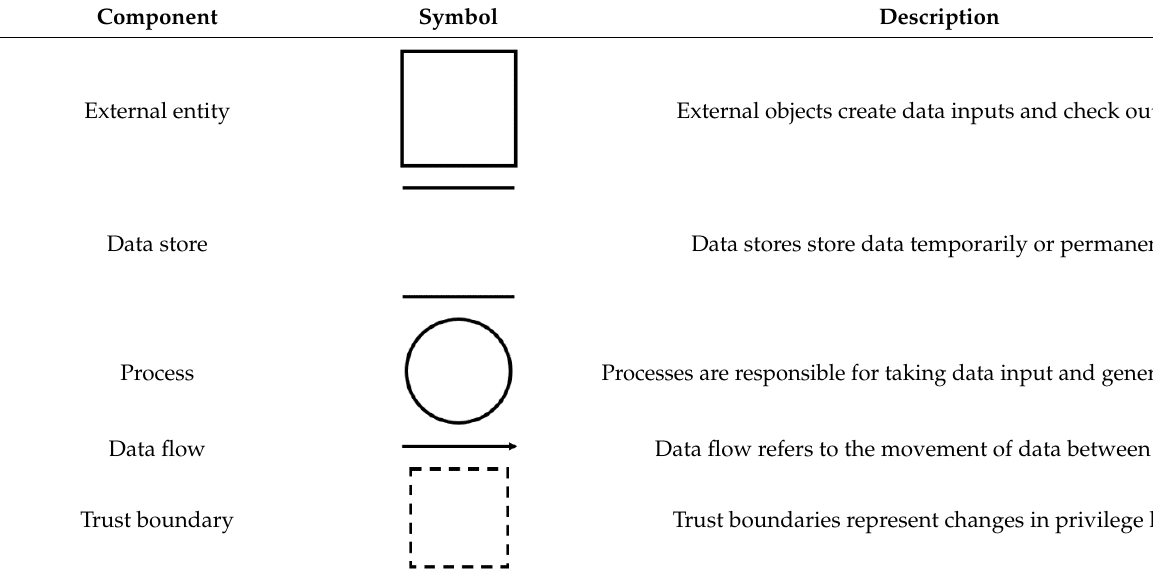
Table 9. Components of a DFD.